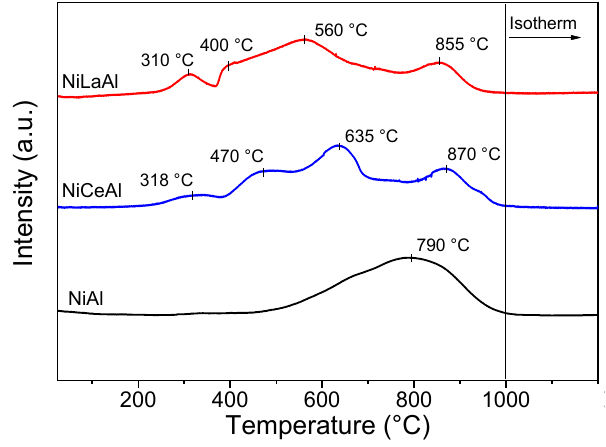
Figure 3. TPR profiles of calcined catalysts.